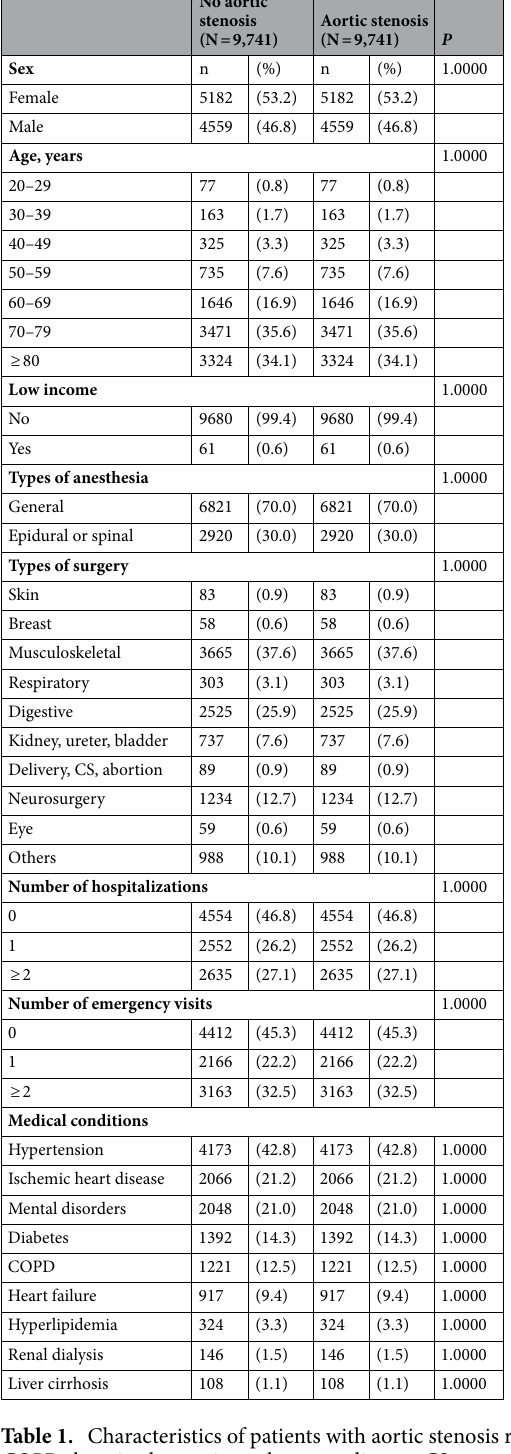
Table 1. Characteristics of patients with aortic stenosis received non-cardiac surgeries (after matching). COPD chronic obstructive pulmonary disease, CS cesarean